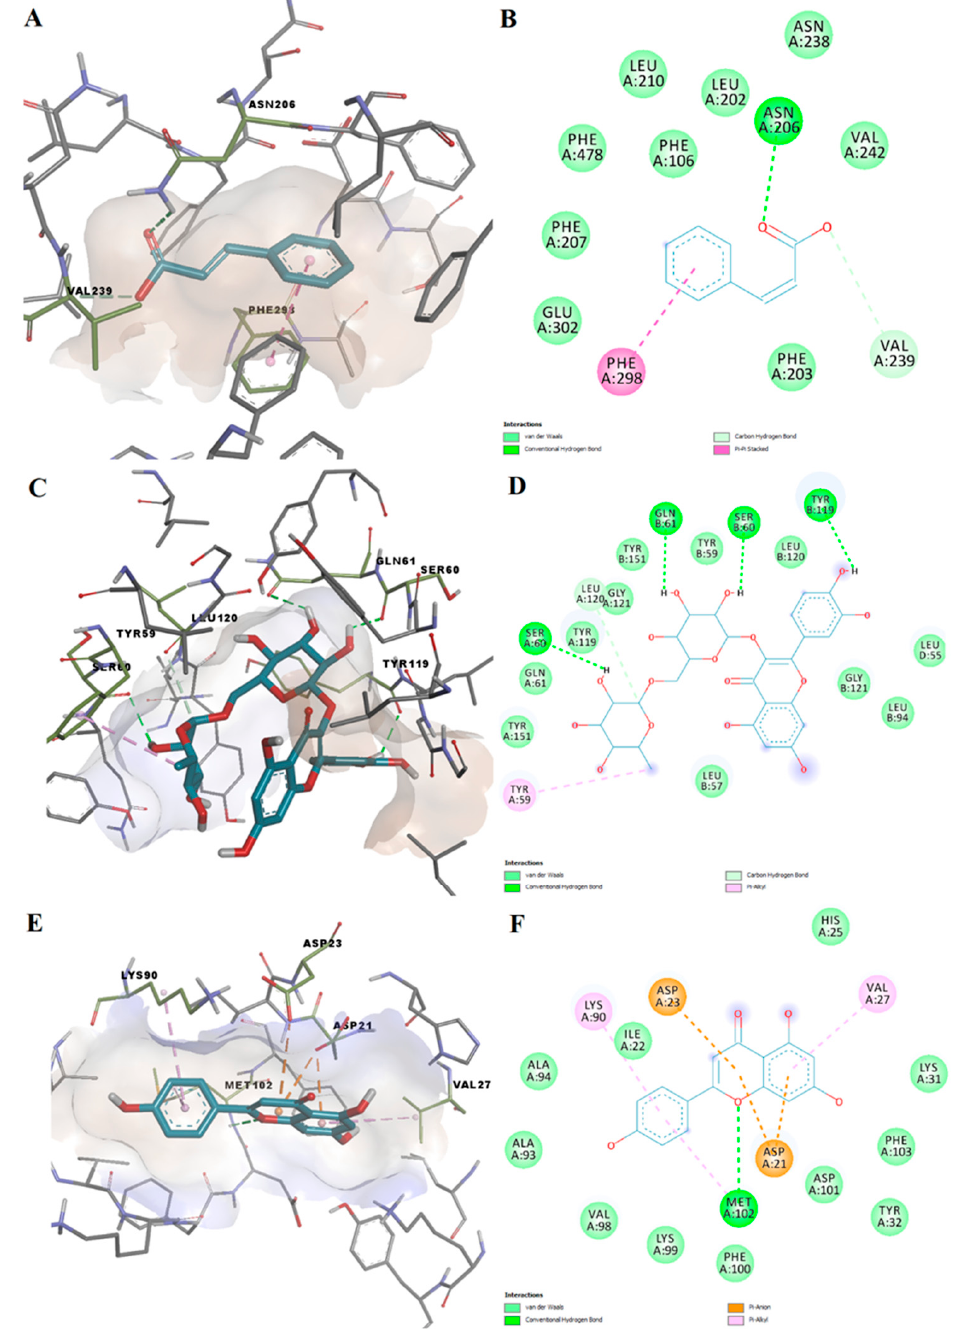
Figure 8. Docking poses and molecular interactions between docked ligands and target proteins. ( A ) 3D conformation of predicted cinnamic acid-CYP2E1 complex; ( B ) 2D depiction of